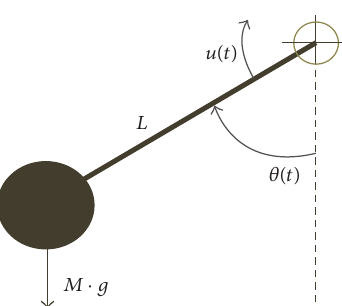
Figure 2: Plant used to test the proposed control.